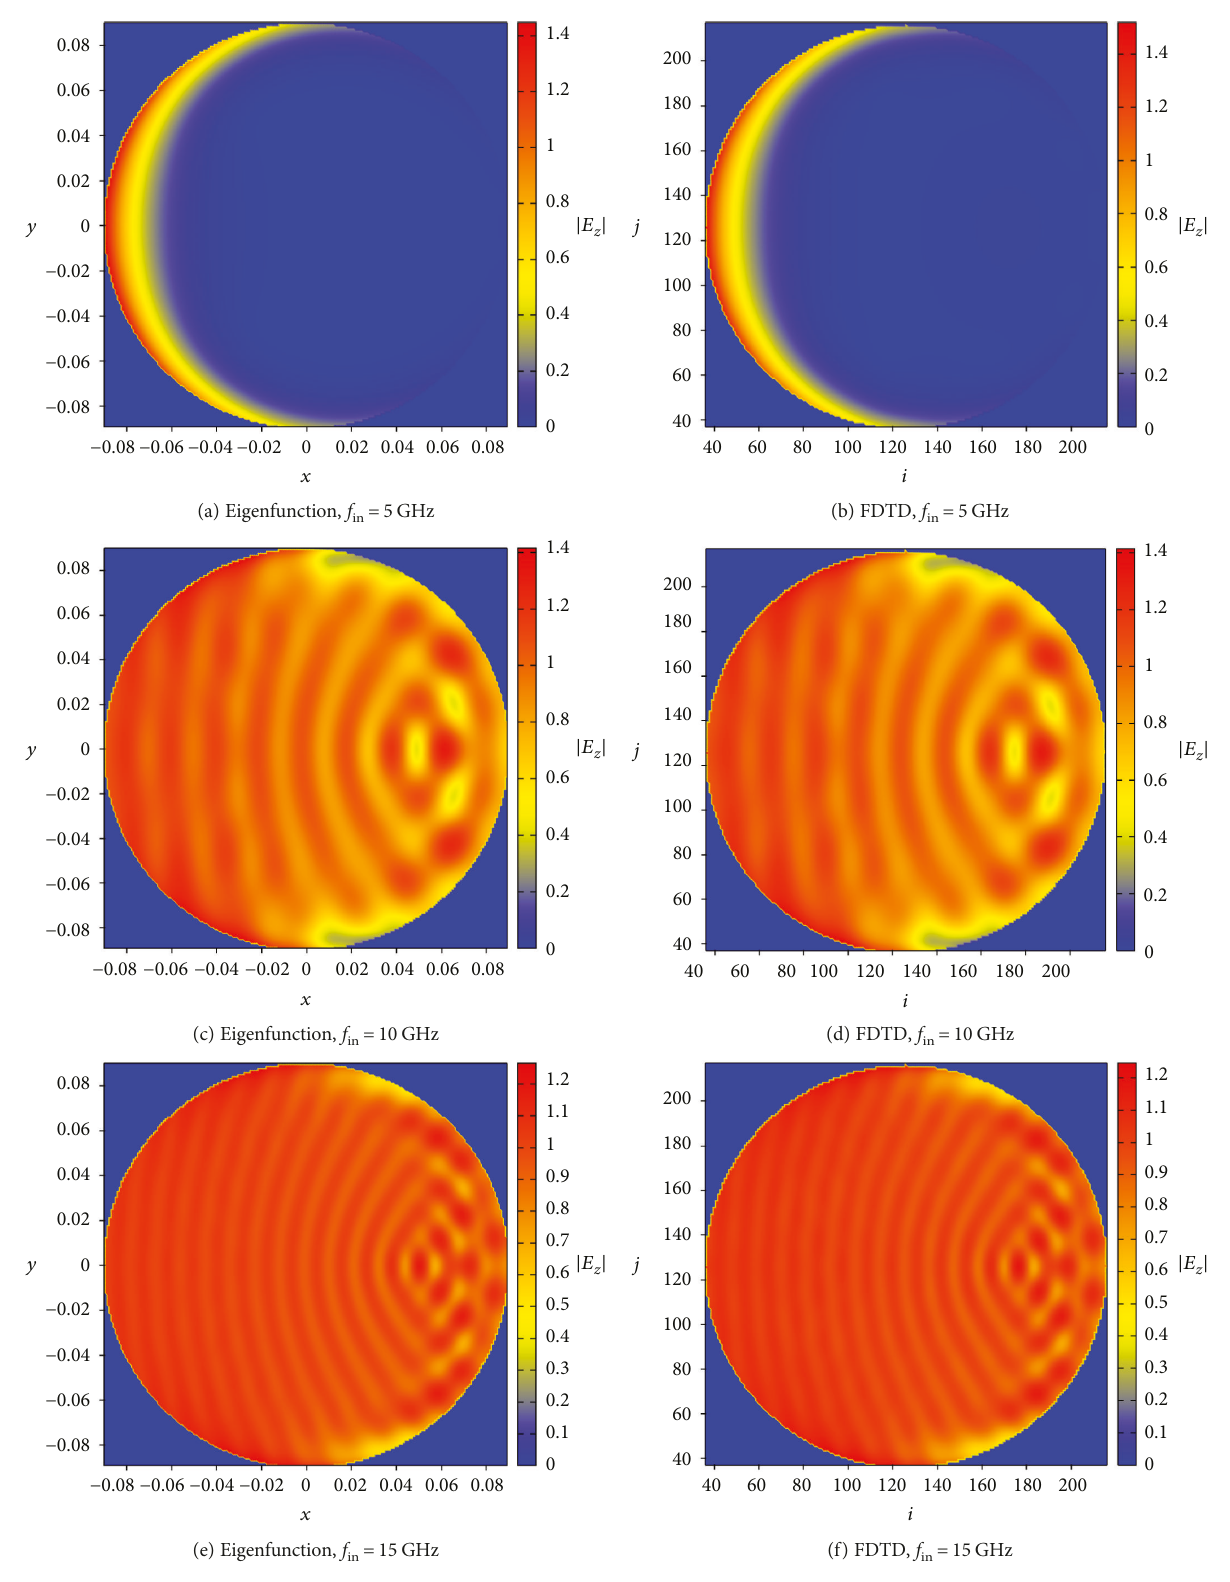
Figure 6: Comparison between the magnitude of the electric fi eld, in volts/meter, within the cylinder obtained by the eigenfunction method and the FDTD simulation for di ff erent incident frequencies; electron density is set to n to ν =500 × 10 6